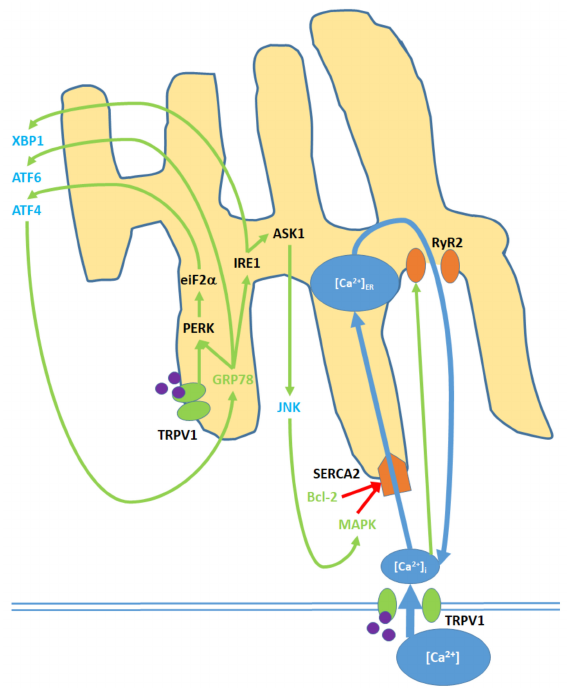
Figure 4. Cell membrane and ER TRPV1 activation promote ER stress through the modulation of [Ca 2 + ] ER , activation of various kinases, the upregulation of nuclear transcription factors, and the release of JNK into the cytosol. TRPV1 proteins localized to the ER membrane contribute only to protein signaling within the ER, while TRPV1 channels in the cell membrane promote both [Ca 2 + ] i and protein signaling. Initial Ca 2 + entry into the ER occurs through the SERCA2 pump, which is eventually